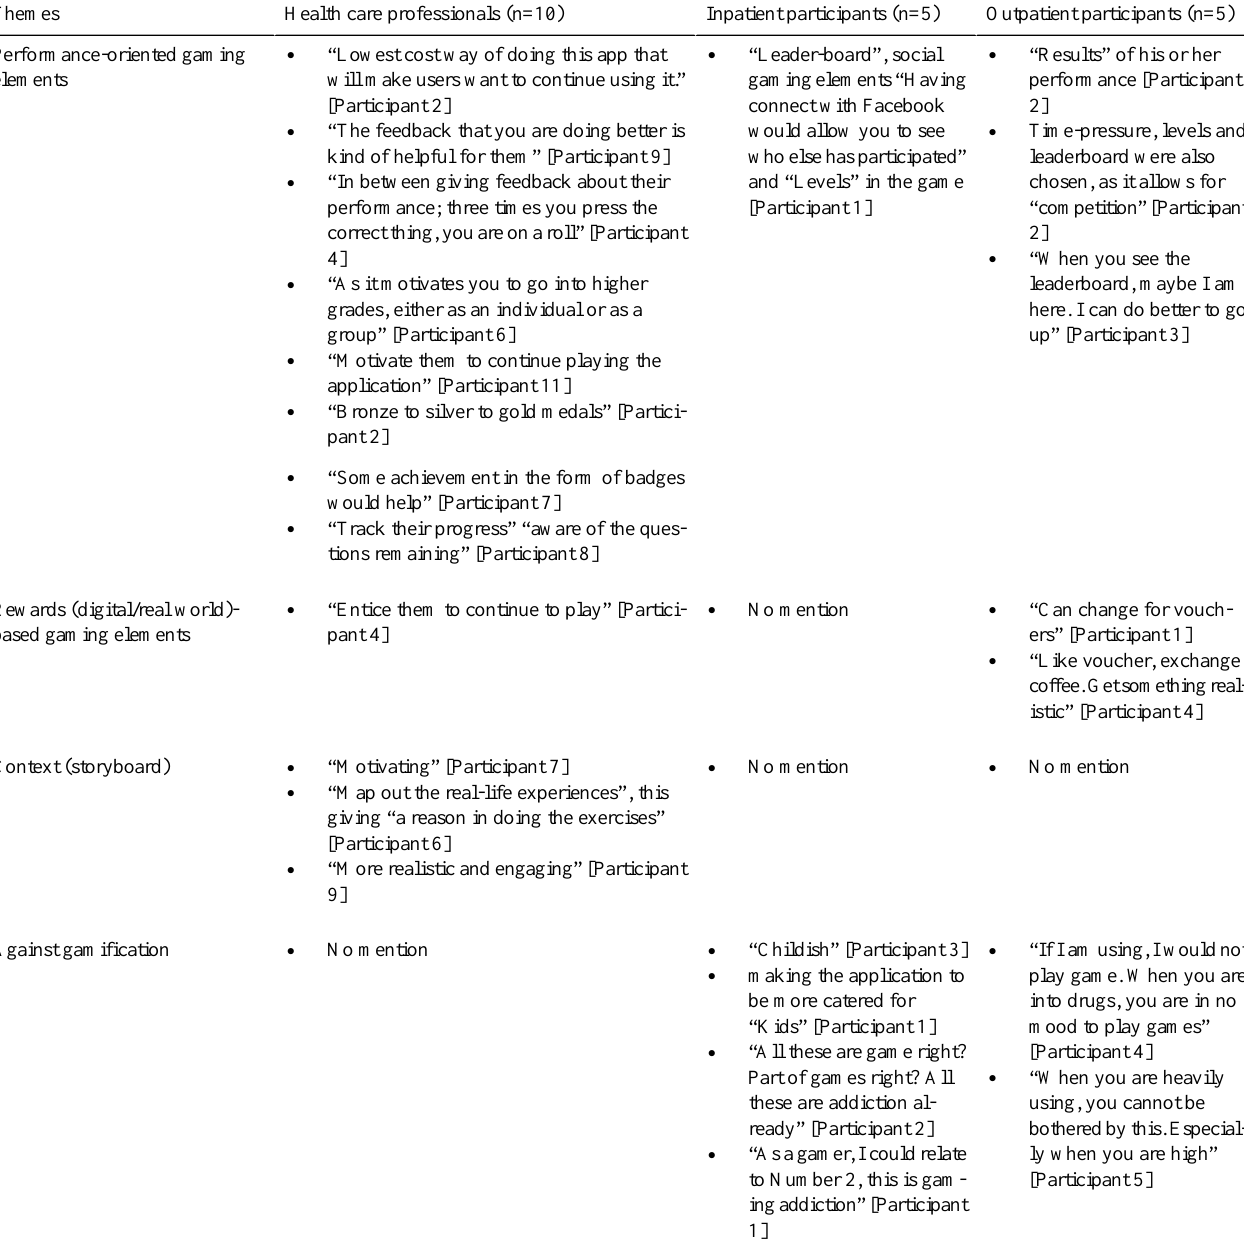
Table 4. Themes related to gamification elements for the existing